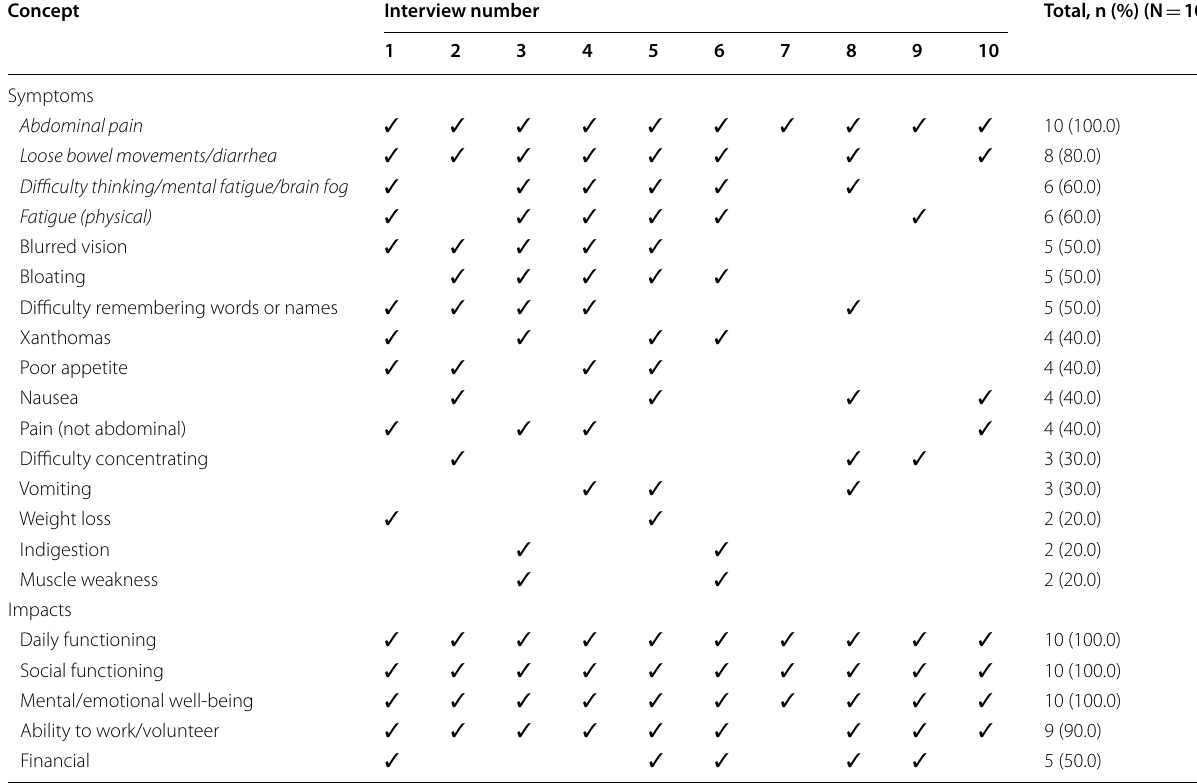
Symptoms in italics are included in the final FCS Symptoms and Impacts